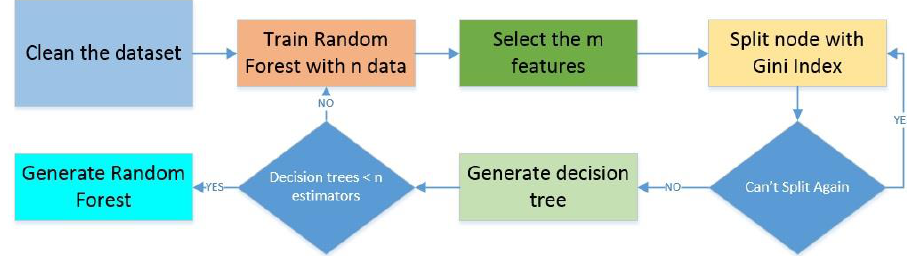
Figure 5. Random forest algorithm; adapted from [34].